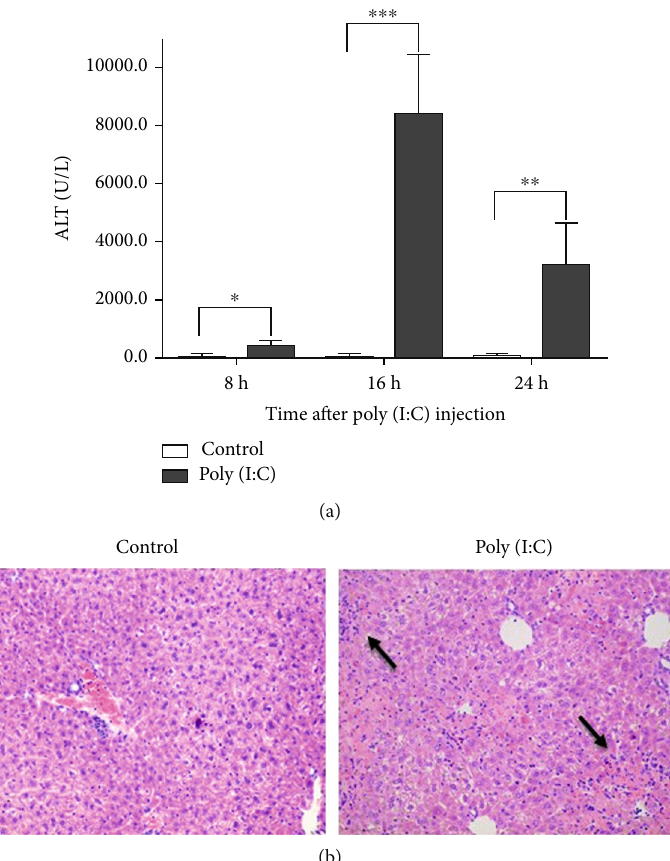
Figure 1: TLR3 signaling triggered acute hepatitis. (a) BALB/c mice were injected with poly(I:C) (1.5 μ g/mouse) and D-GalN(10mg/ mouse). At the 8h, 16 h, and 24 h time points, serum ALT was measured. The fi gure shows the results of one representative experiment with eight mice per group, and data are shown as mean + SEM ; ∗ p < 0 : 05 , ∗∗ p < 0 : 01 , ∗∗∗ p < 0 : 001 . (b) The mice were sacri fi ced at 24 h after treatment with saline or poly(I:C). Liver sections were stained with H&E staining (size bar represents 50 μ m). Arrows indicate necrotic areas with accumulation of mononuclear cells.